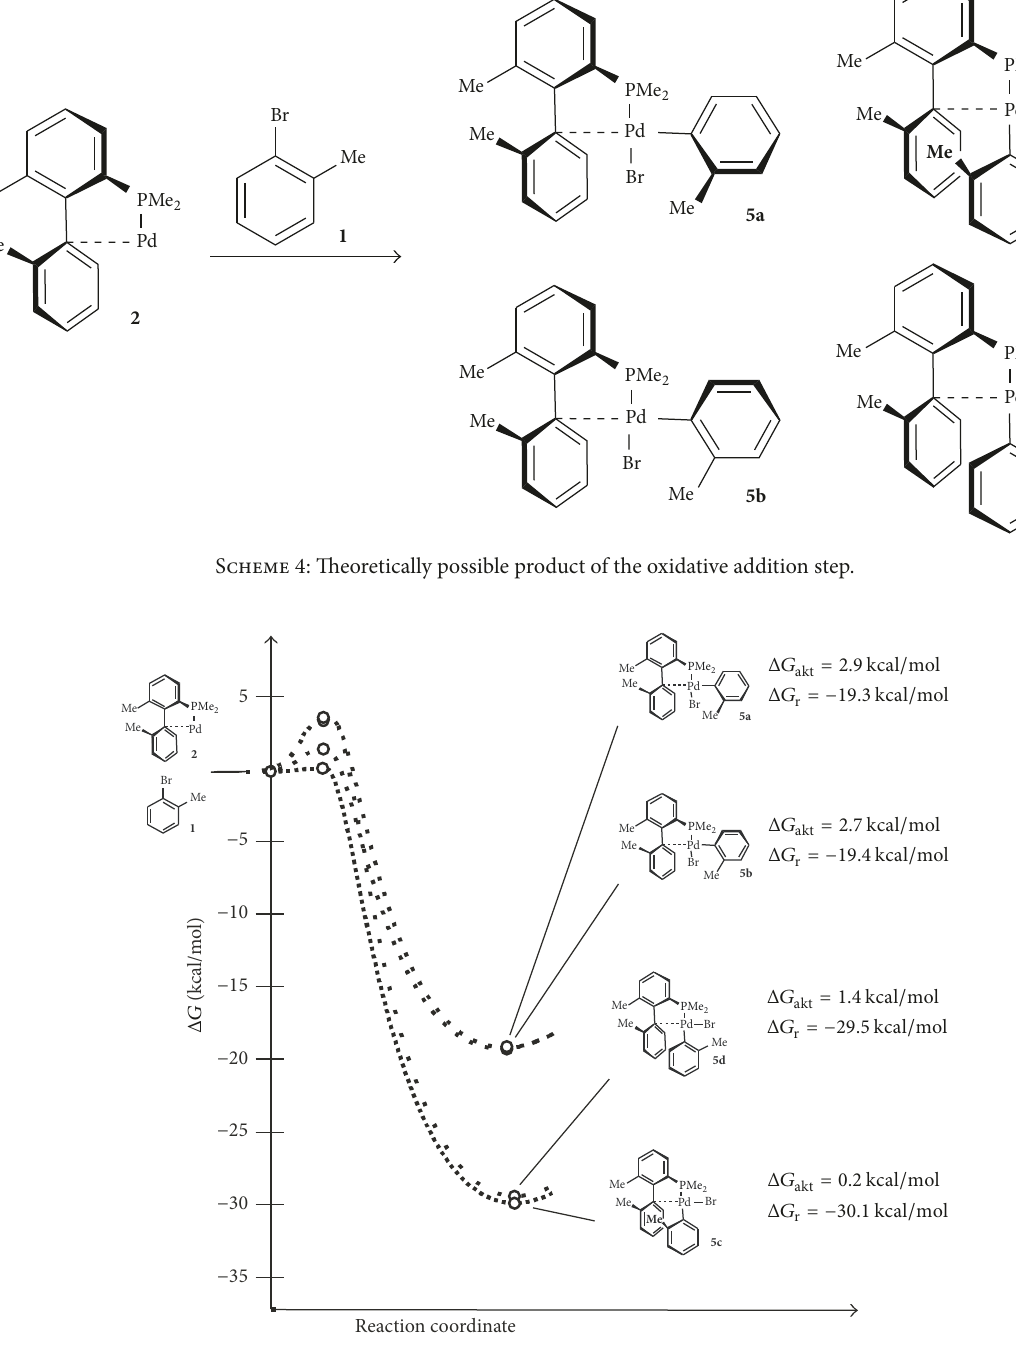
Figure 4: Energy profiles for competitive channels of oxidative addition